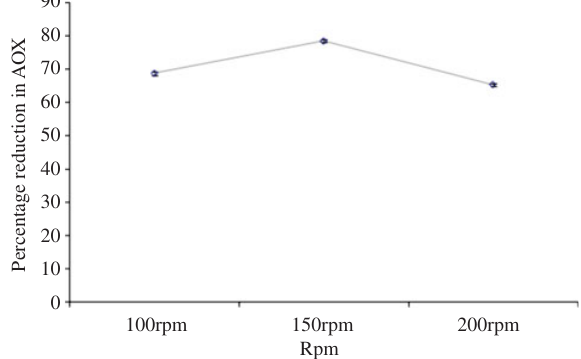
Fig. 6. Effect of rate of agitation on the AOX reduction of pulp and paper mill effluent (n (cid:4)